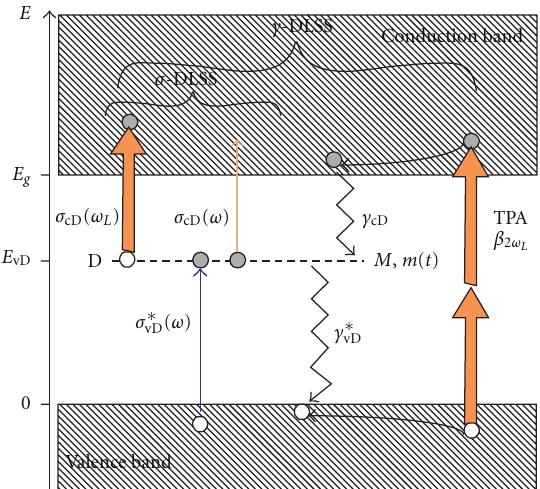
Figure 3: Scheme of optical transitions for DLSS calculations in the case of donor ( D ) states. Fat arrows, DL photoionization σ cD ( ω L ) transitions with laser quanta absorption, and interband two-photon (TPA) excitation of a crystal β (2 ω L ). Thin arrows, probe light absorption. Broken lines, free carriers